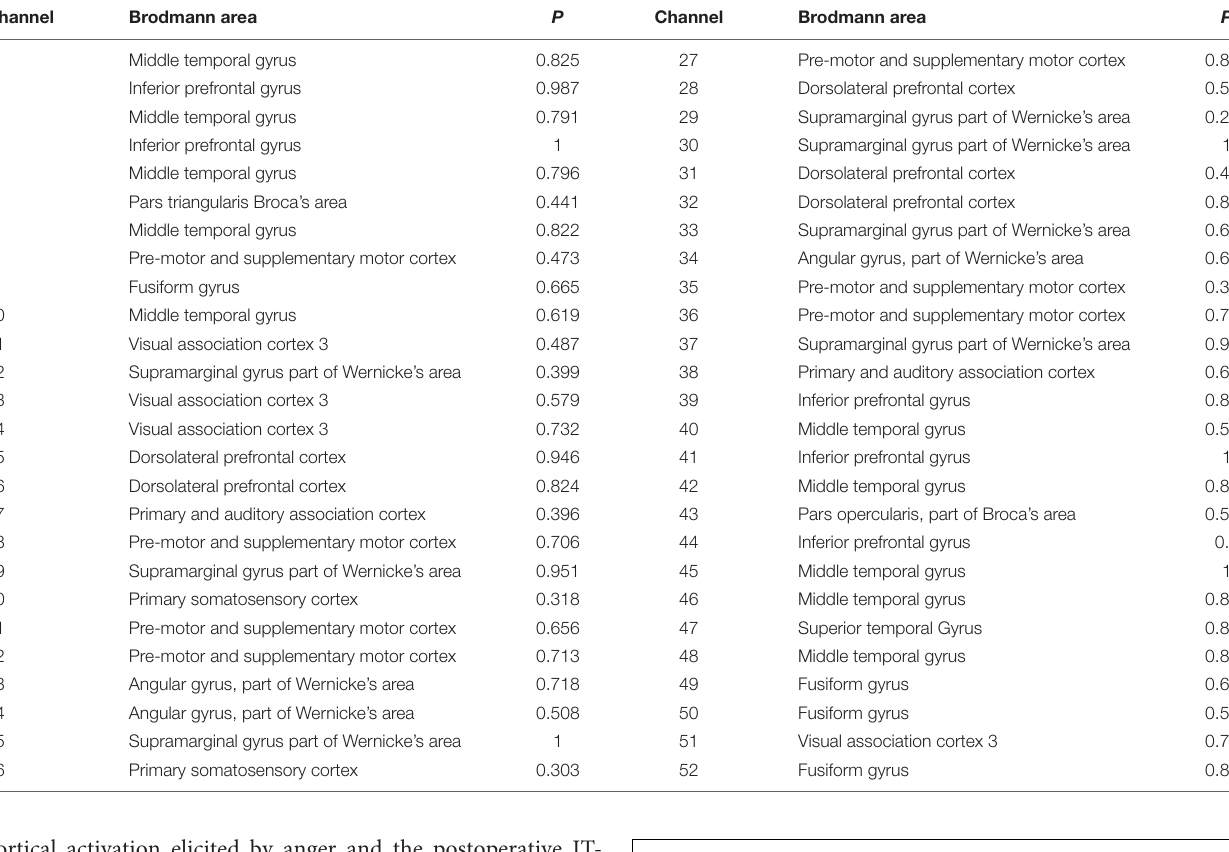
TABLE 2 | Channels and corresponding brain regions.